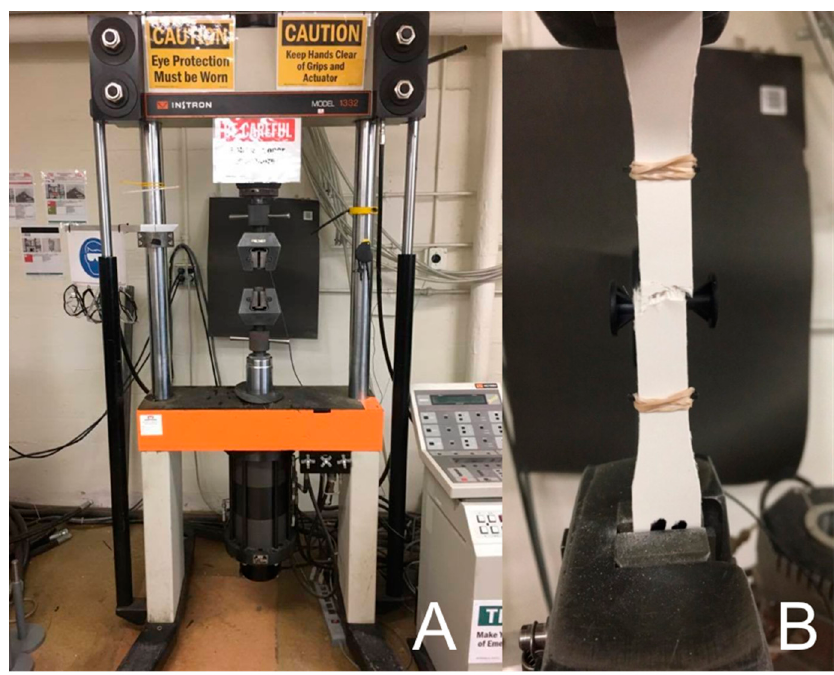
Figure 3. ( A ) INSTRON model 1332 used to perform the uniaxial tensile and flexural tests in this work; ( B ) A tensile failed specimen in clamps with an extensometer attached.